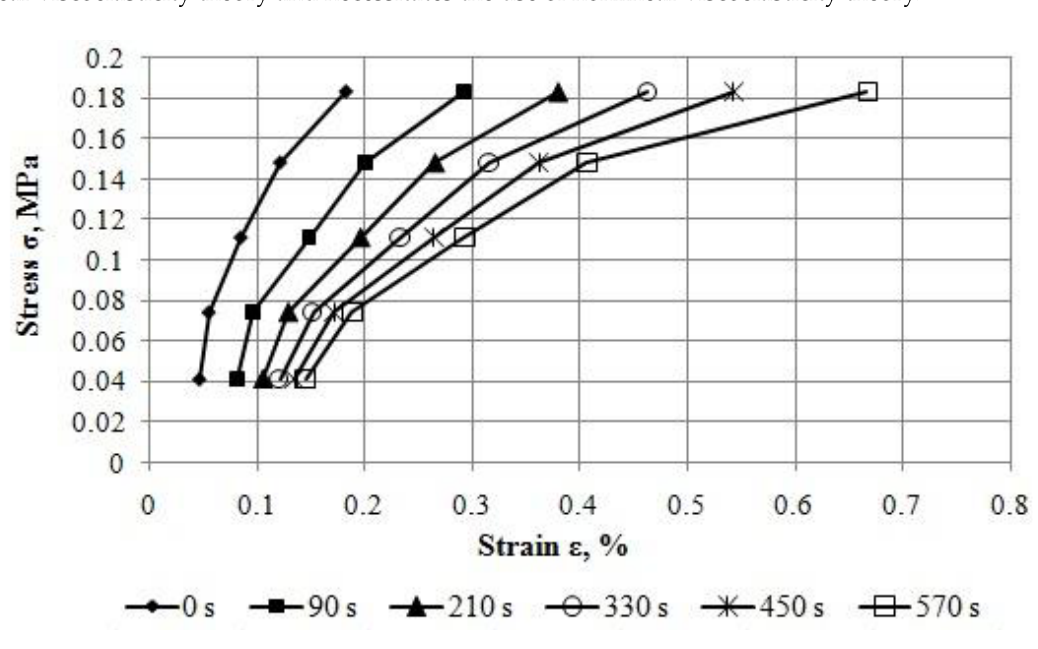
Figure 8. Isochronous creep curves of the asphalt concrete.